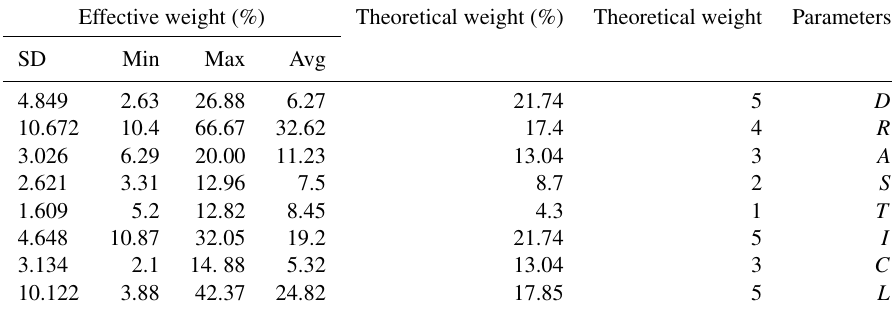
Table 11. Statistical results of SPSA in the CDRASTIC